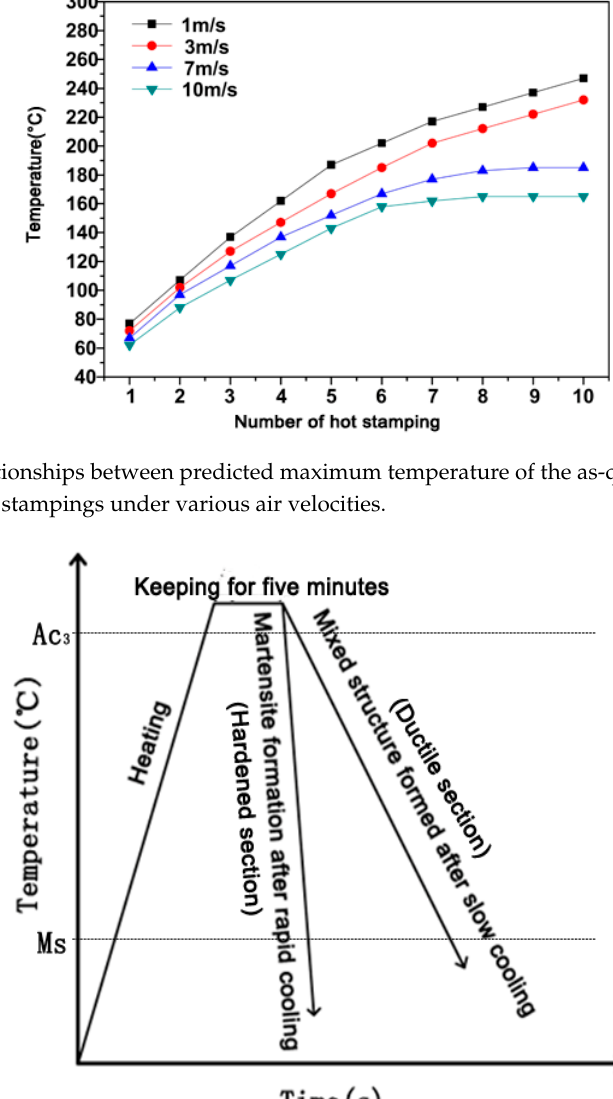
Figure 6. The relationships between predicted maximum temperature of the as-quenched blanks and the number of hot stampings under various air velocities.